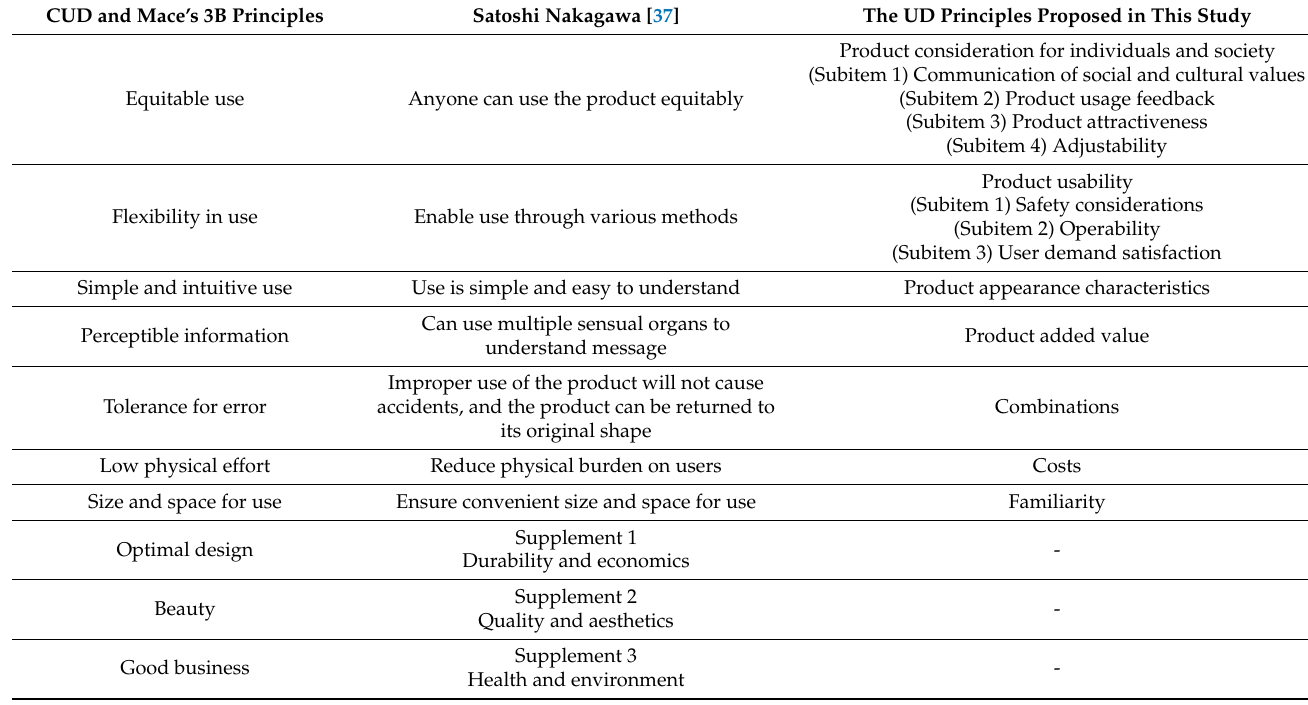
Table 2. Comparison and difference with UD